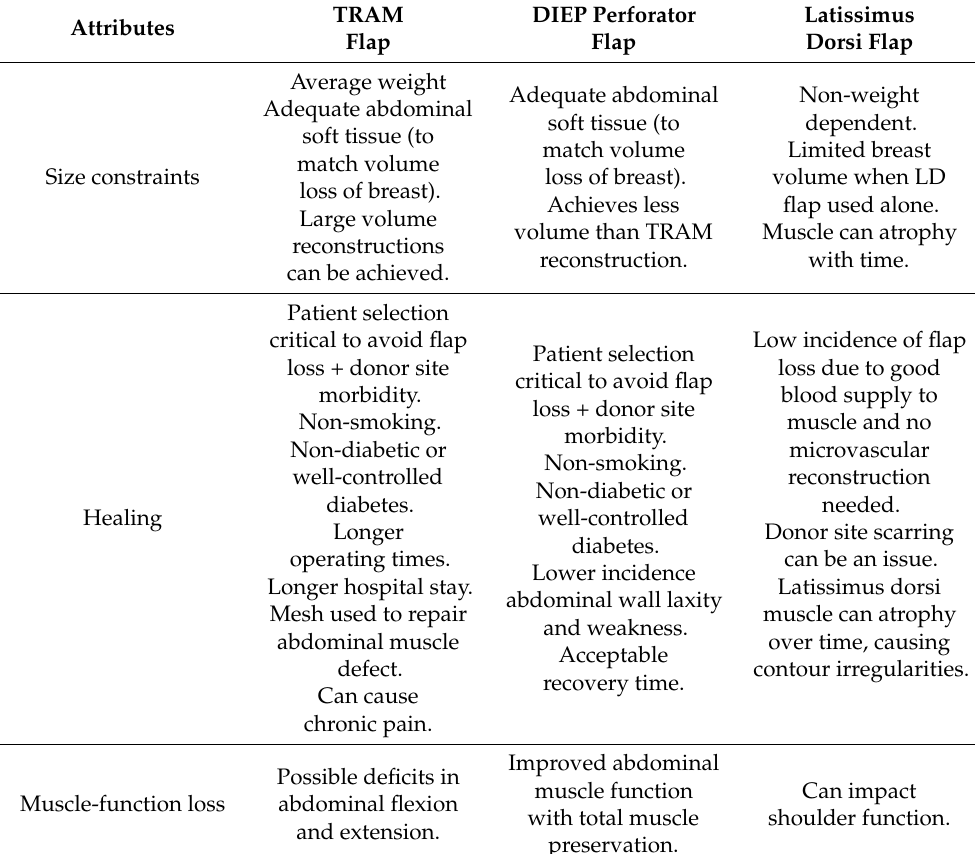
Latissimus Dorsi Flap Non-weight dependent. Limited breast volume when